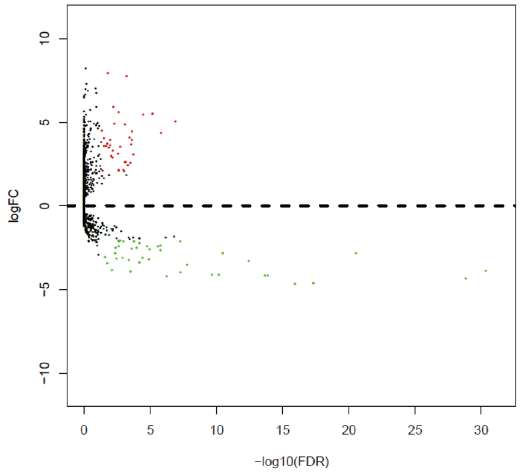
Figure 1. Volcano plot of differentially expressed miRNAs. The red dot represents up-regulated miRNA, and green dot represents down-regulated